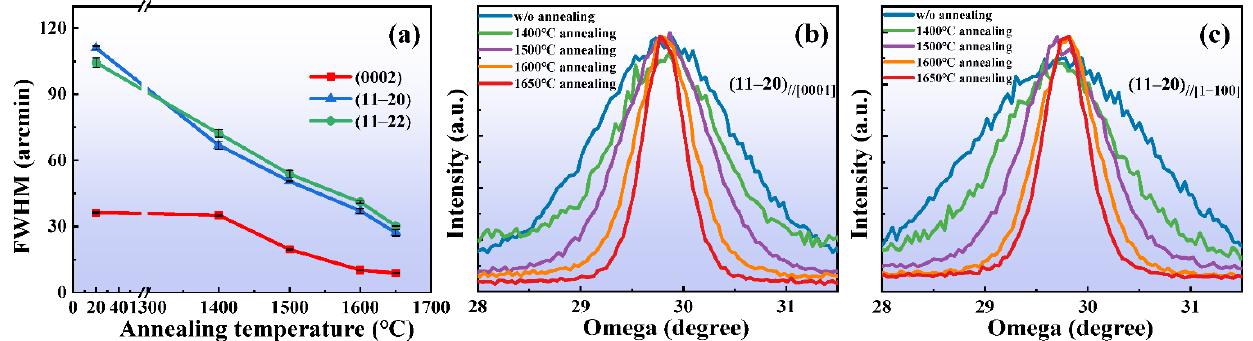
Figure 2. ( a ) The FWHM of rocking curves of polar (0002), semi-polar (11 – 22) and non-polar (11 – 20) films after annealing at 1400 – 1650 °C as a function of annealing temperature. The XRC of the non- polar (11 – 20) film along ( b ) [0001] direction and ( c ) [1 – 100] direction without and with annealing.